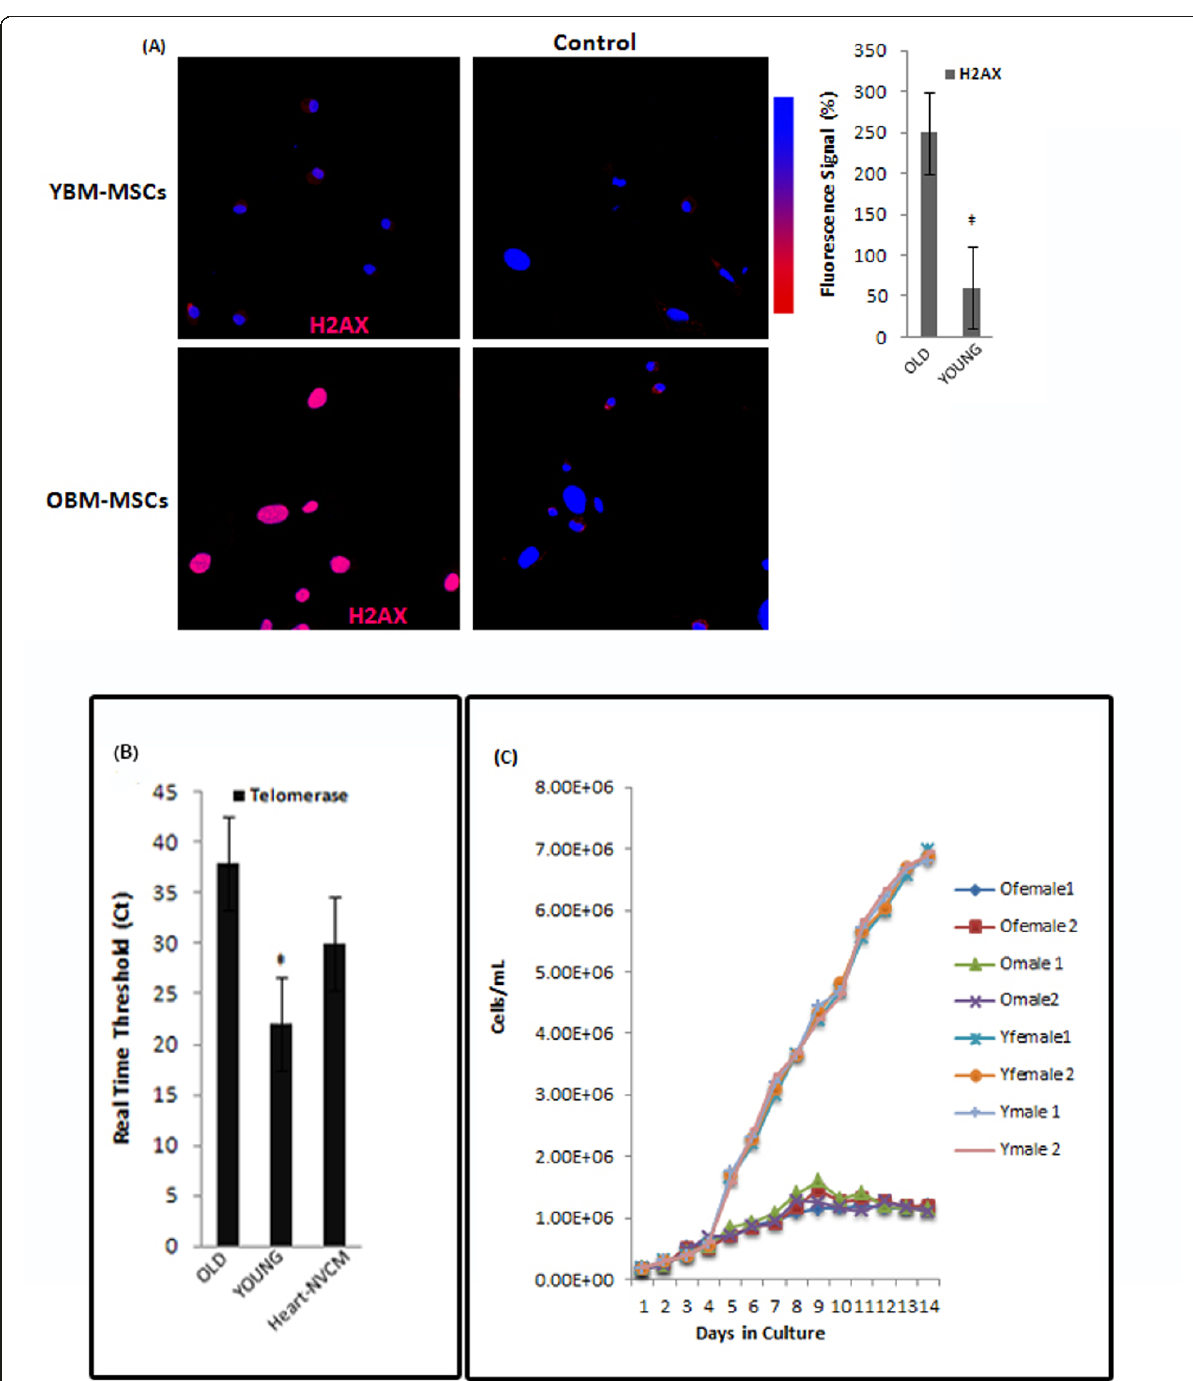
Figure 6 Telomerase activity, growth and immunocytochemical assessment of DNA double strand break in young and old BM-MSCs: (A) Representative micrographs of anti- g -H2AX staining in cultured BM-MSCs from each experimental group. (B) Columns show comparison of telomerase activity between young and old BM-MSCs by qPCR. C q values for young BM-MSCs are significantly lower indicating higher enzymatically active telomerase. Data represent Mean ± SEM for three biologically independent experiments (n = 3). The ‘‡’ sign indicates a significant difference between the indicated group and any passage 3 groups from older donors ( p < 0.05). (C) Passage 0 BM-MSCs from individual young and old rats were trypsinized, and enumerated with a Cedex HiRes non-flow imaging cytometer over 15